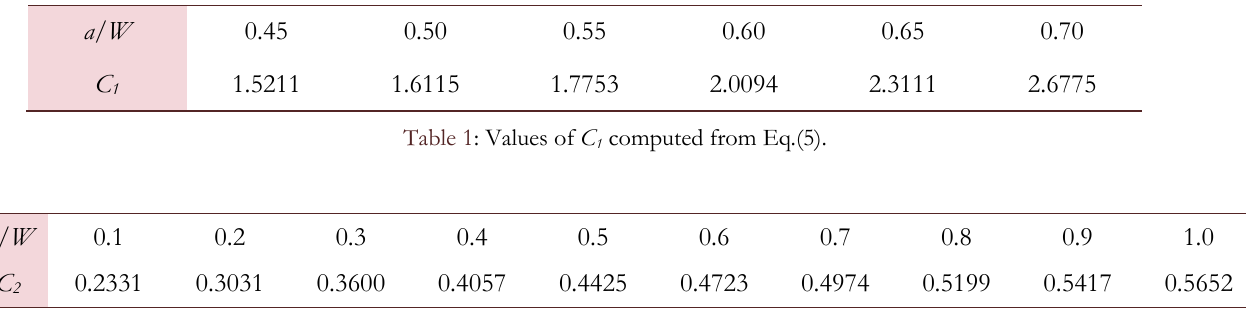
Table 2: Values of C 2 computed from Eq.(8).